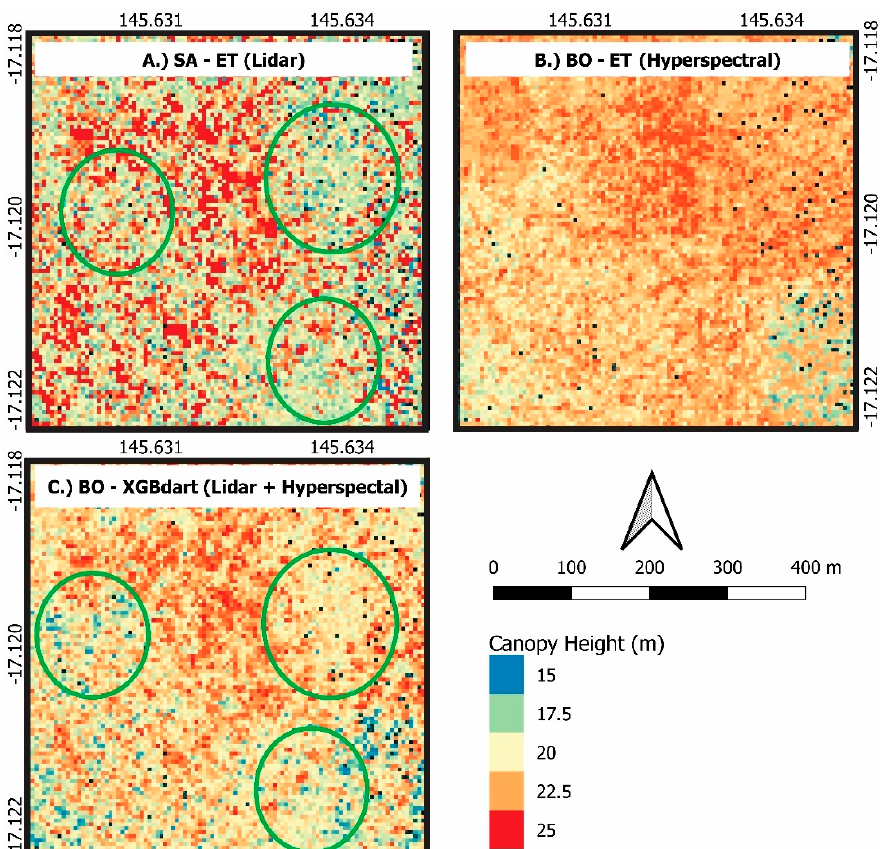
Figure 11. The height maps produced by using the best model found by using different datasets. ( A ) Lidar metrics only (SA-ET), ( B ) hyperspectral bands only (BO-ET), and ( C ) combination of lidar and hyperspectral (BO-XGBdart). Green circles showed the regions of lower tree height which went undetected by the hyperspectral model.